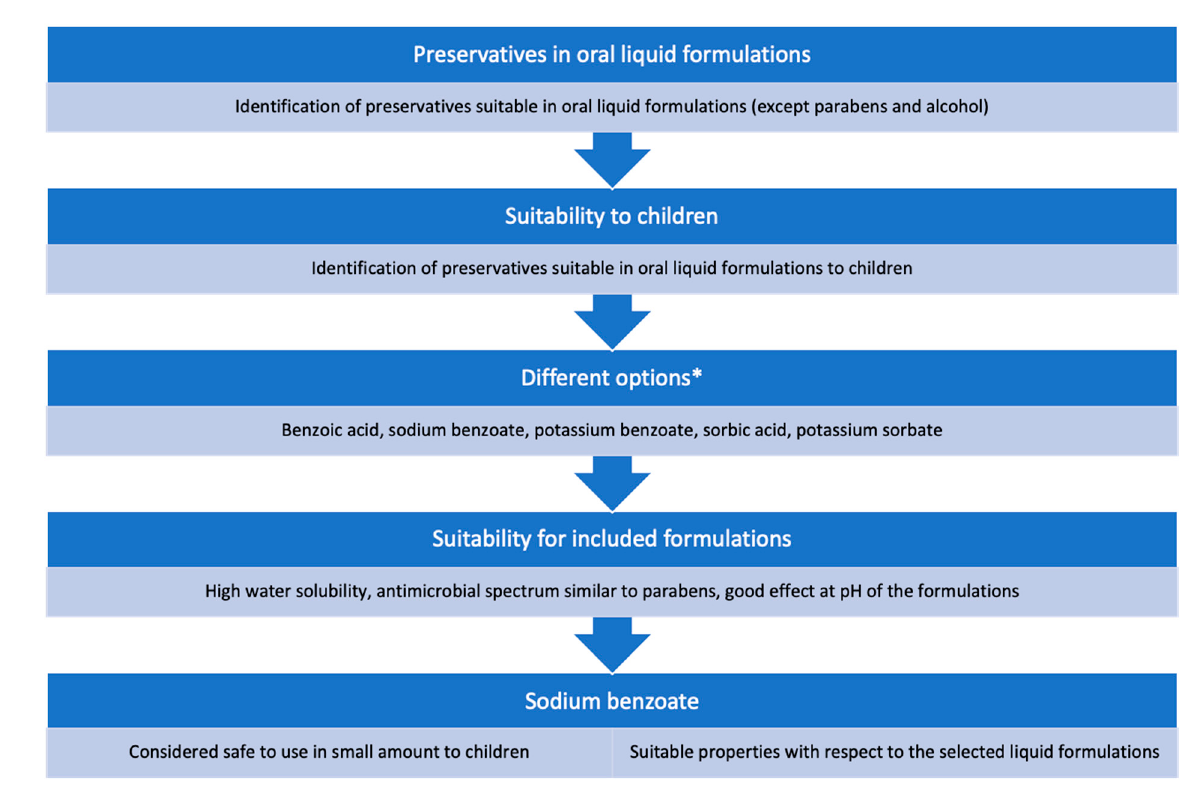
Figure 1. Flow chart describing the process to select an appropriate preservative in order to substitute methyl parahydroxybenzoate. * Benzoic acid: solubility in water at 20 °C 1 in 300, optimal antimicrobial pH 2.5–4.5, effective against bacteria, fungi, mold and yeast. Sodium benzoate: solubility in water at 20 °C 1 in 1.8, optimal antimicrobial pH 2–5, effective against bacteria and fungi. Potassium benzoate: solubility in water at 20 °C 1 in 2.36, optimal antimicrobial pH ≤ 4.5, effective against bacteria and fungi. Sorbic acid: insoluble in water, optimal antimicrobial pH 4.5, effective primarily against fungi. Potassium sorbate: solubility in water at 20 °C 1 in 1.72, optimal antimicrobial pH < 6, effective primarily against fungi [8,22,28,38–40,44].